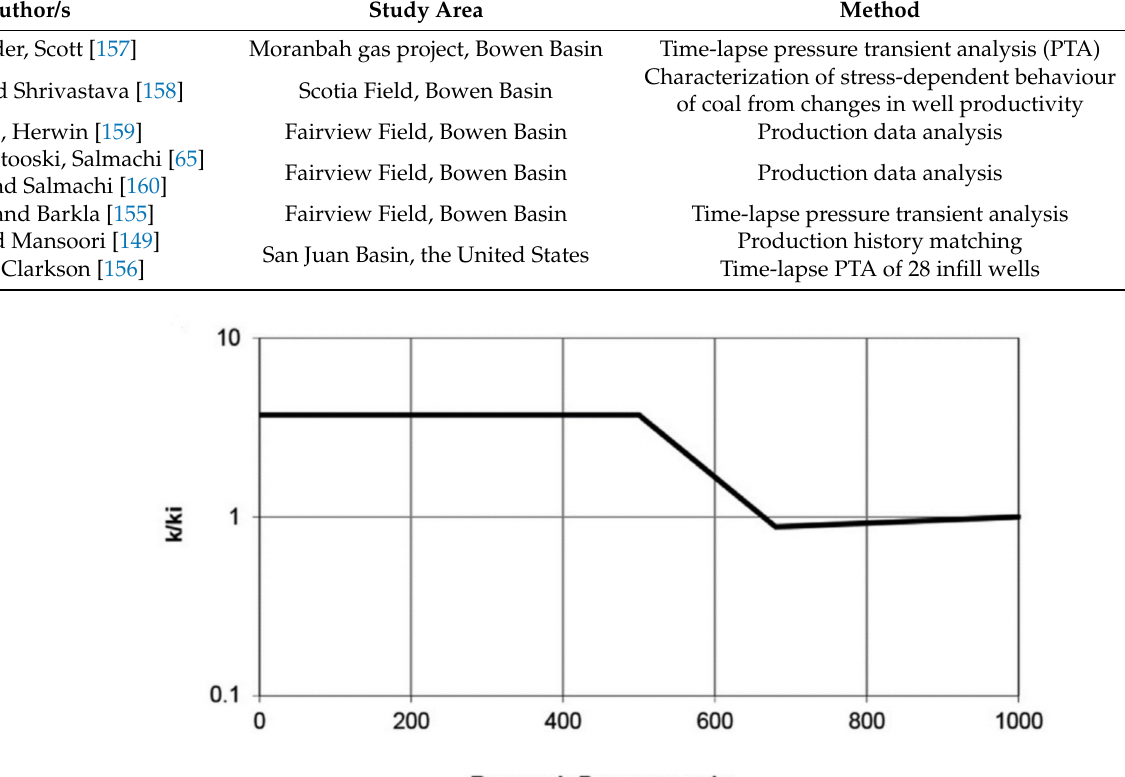
Table 5. Some permeability enhancement studies in the Bowen basin (Australia) and the San Juan Basin in the United States.